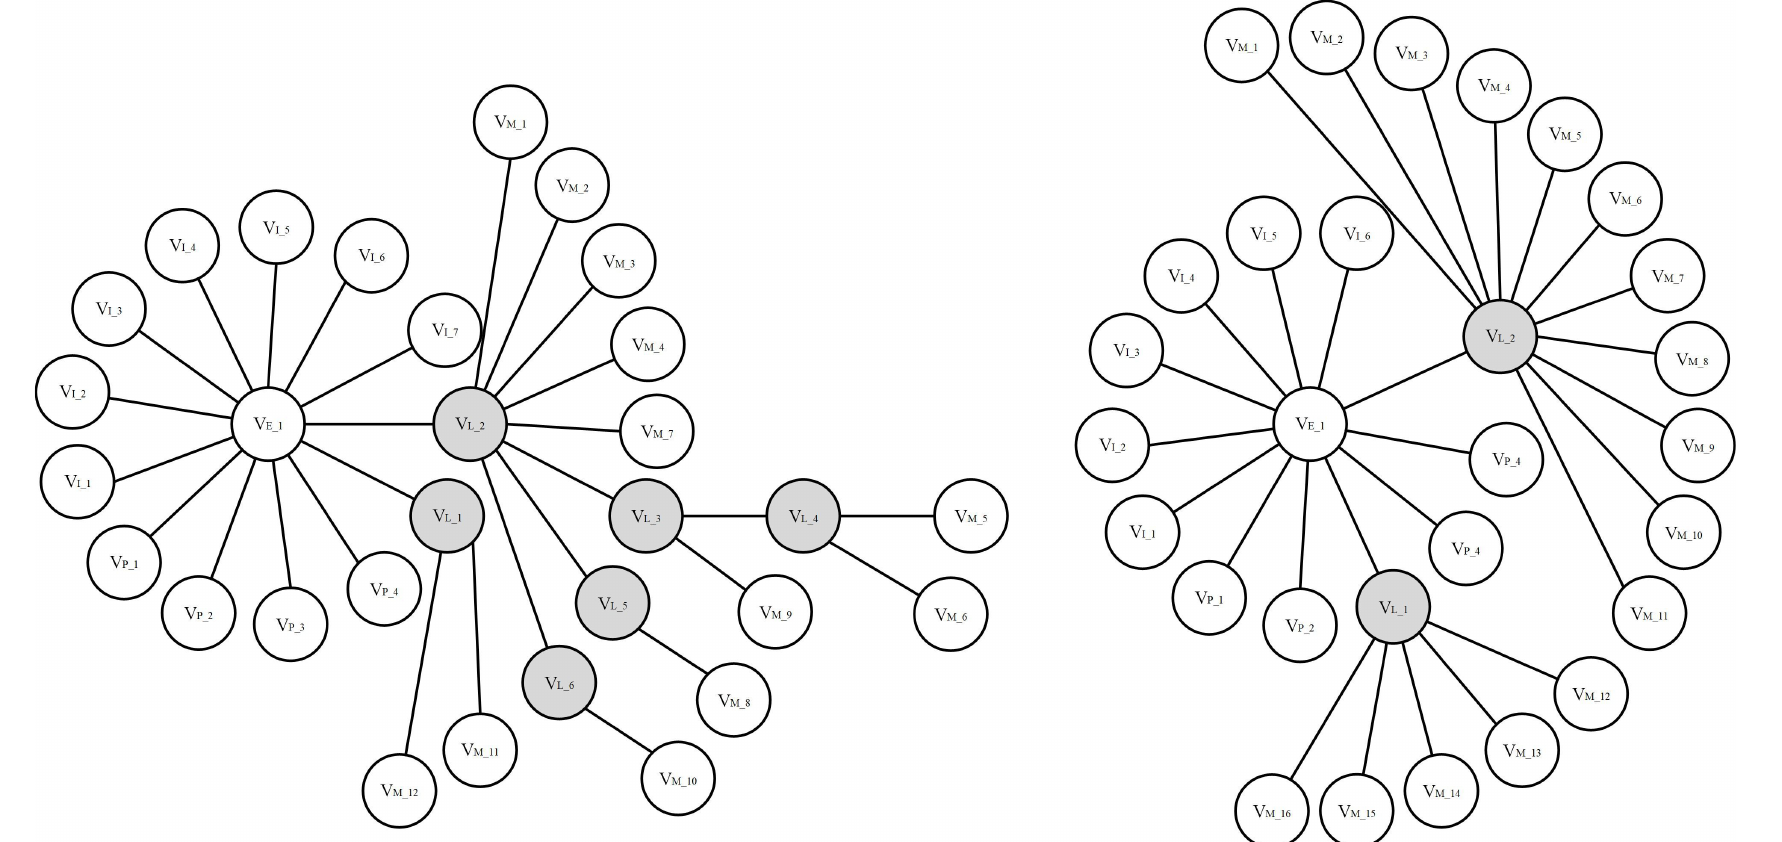
Figure 7. Storm surge disaster cases no. 1 and no.